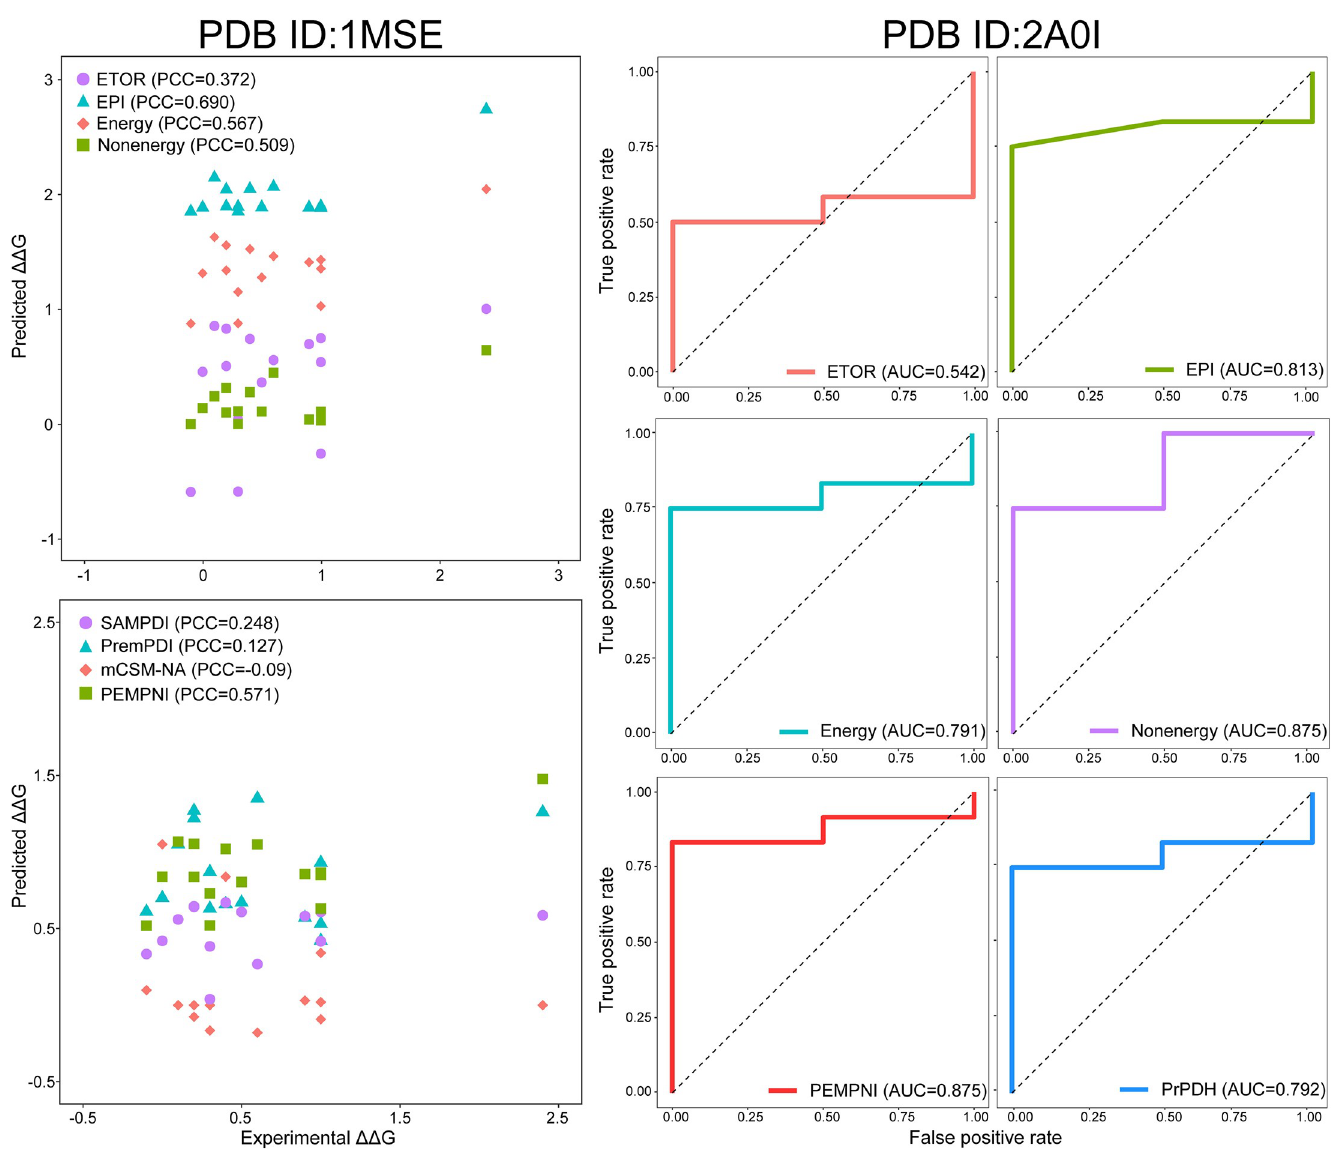
Fig 7. Performance of PEMPNI and other methods on representative protein-DNA complexes.